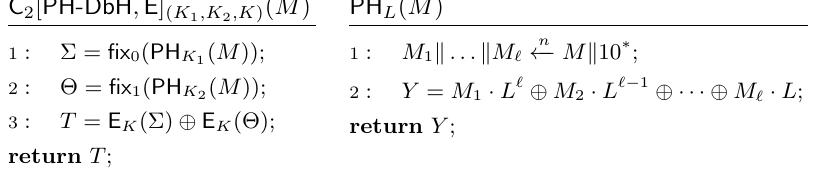
Figure 5.1: The two-keyed Polyhash-based DbHtS construction C 2 [ PH-DbH , E ] with PH- DbH as the underlying double-block hash function. M 1 ∥ M 2 ∥ . . . ∥ M ℓ n ←− M ∥ 10 ∗ denotes the parsing of message M ∥ 10 ∗ into n bit